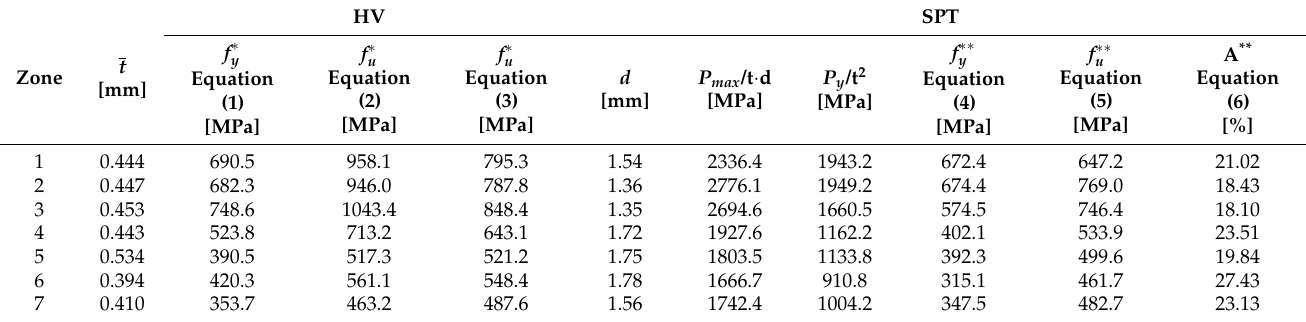
Table 6. Thickness, SPT results, and estimated properties through HV (*) and SPT (**) of the T8 M16 K800 specimen.